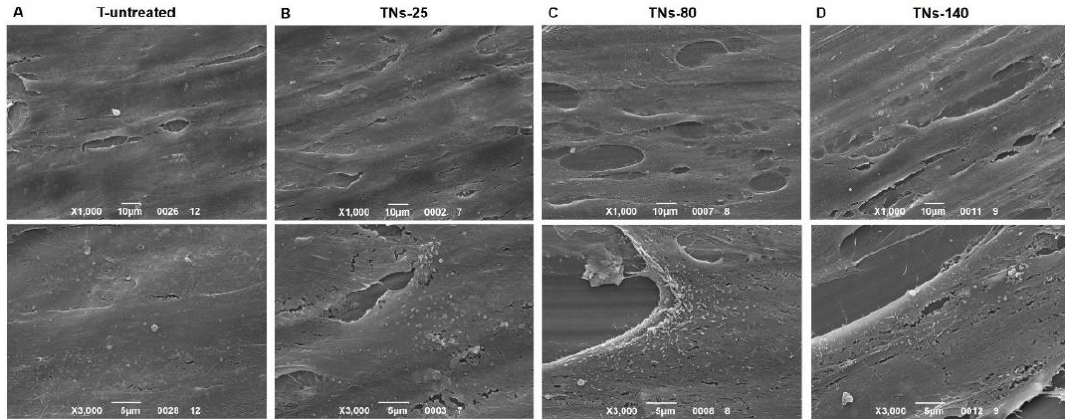
Figure 4. SEM micrographs of the exosome-producing cells. The hMSCs were cultured for 7 days onto ( A ) T-untreated, ( B ) TNs-25, ( C ) TNs-80, and ( D ) TNs-140 surfaces (upper panels ×1000 magnification, lower panels ×3000 magnification).